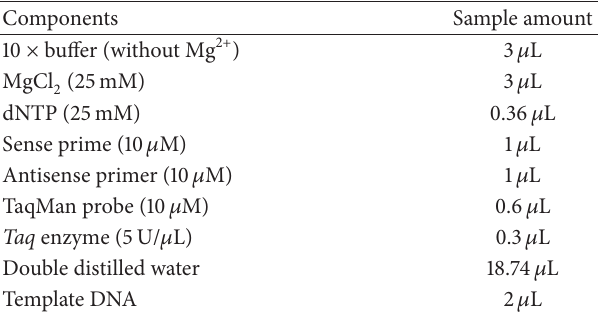
Table 3: Reaction system for real-time fluorescence quantitative PCR.